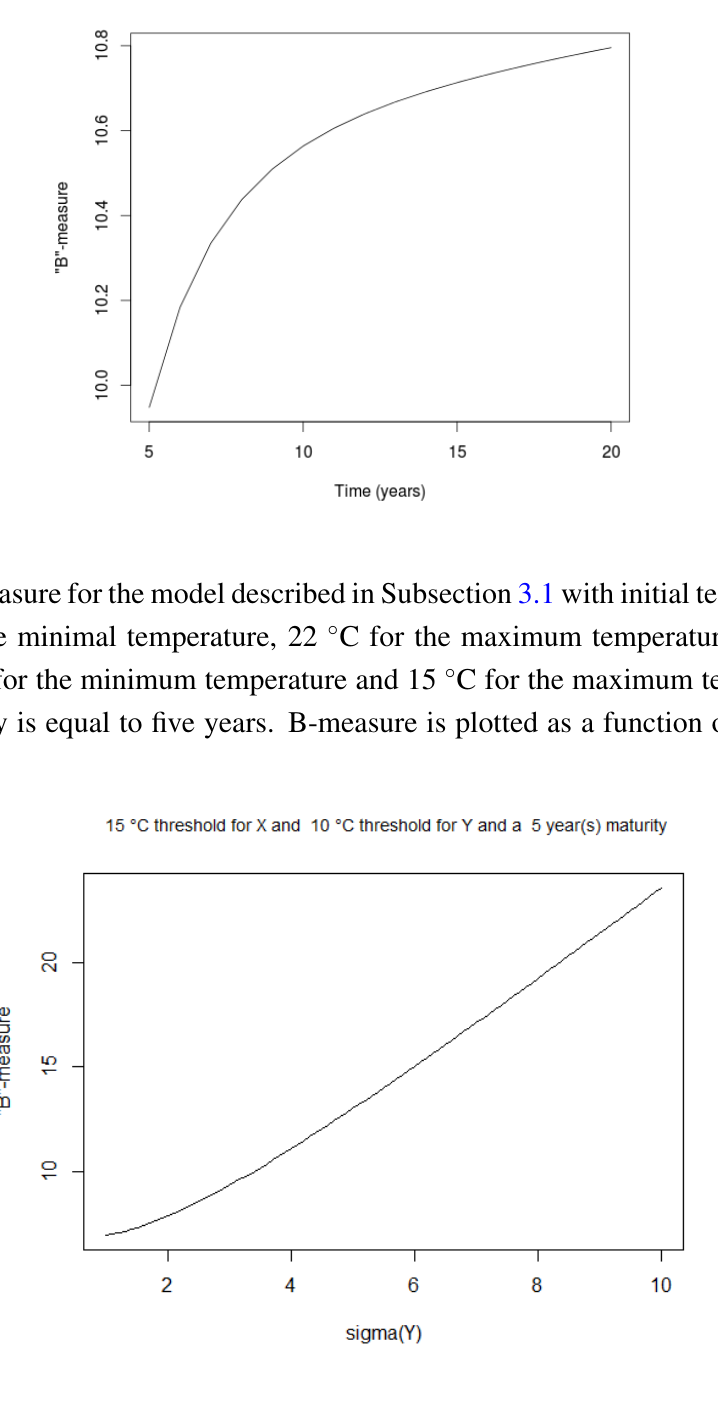
Figure 6. B-measure for the model described in Subsection 3.1 with initial temperature equal to 15 ◦ C for the minimal temperature, 22 ◦ C for the maximum temperature and threshold equal to 10 ◦ C for the minimum temperature and 15 ◦ C for the maximum temperature. B-measure is plotted as a function of the time of maturity (from five to 20 years).